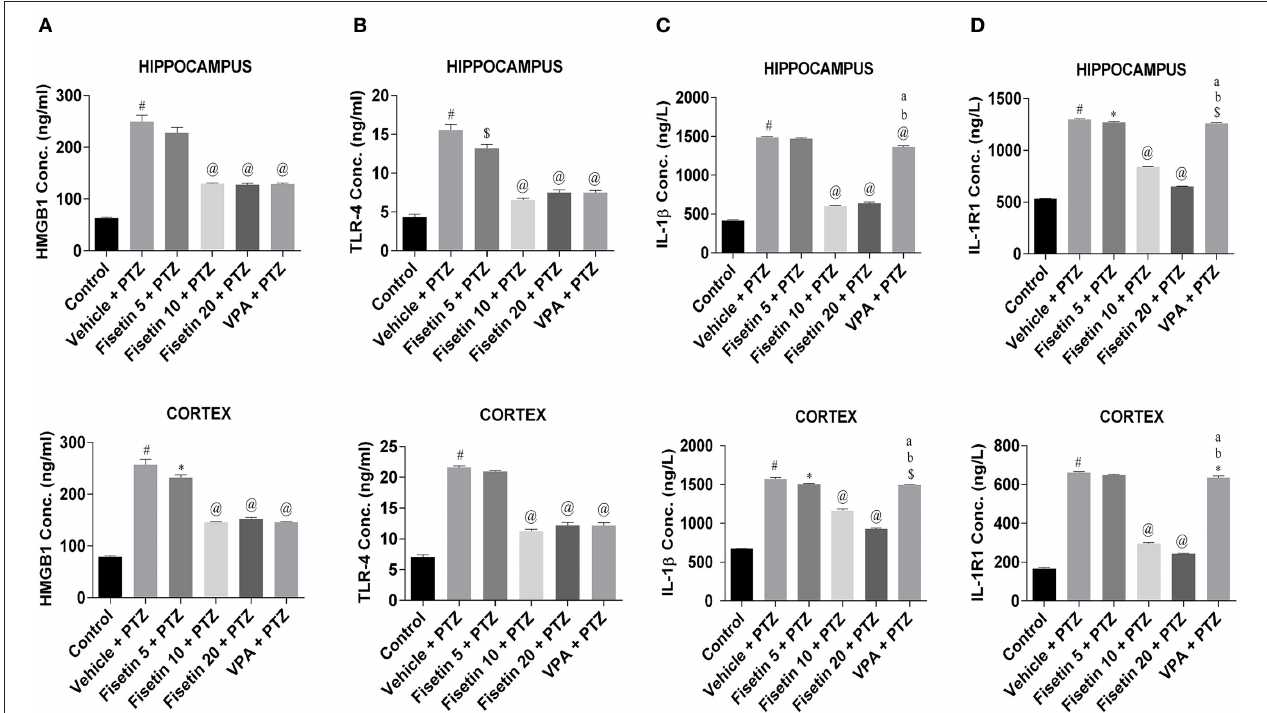
FIGURE 3 | Effect of Fisetin Administration on HMGB1, TLR-4, IL-1b, and IL-1R1 Levels in the Hippocampus and Cortex of Experimental Mice. The concentrations were measured in the hippocampus and cortex of experimental animals using ELISA kits. Fisetin administration significantly lowered the levels of cytokines in a dose-dependent manner in the hippocampus and cortex tissues. Data were analyzed by one-way ANOVA followed by Tukey’s multiple comparison test ( n = 6) and expressed as mean ± SEM. # p < 0.001 as compared with control; * p < 0.05 as compared with vehicle + PTZ group; $ p < 0.01 as compared with vehicle + PTZ group; @ p < 0.001 as compared with vehicle + PTZ group; a p < 0.001 as compared with fisetin 10 + PTZ group, and b p < 0.001 as compared to fisetin 20 + PTZ